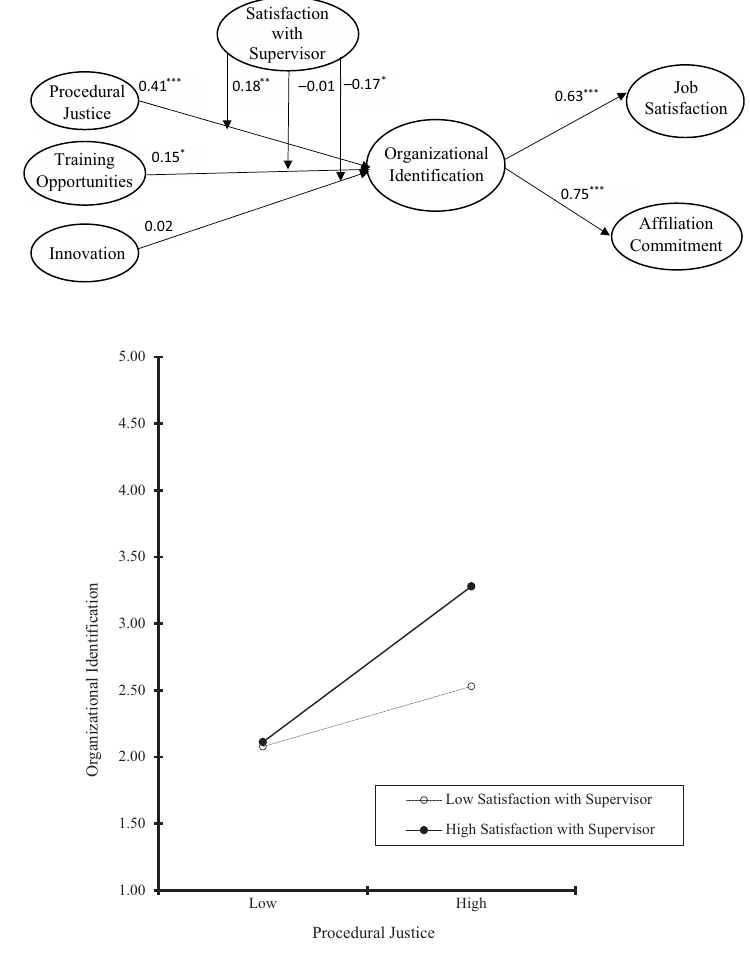
Figure 2. Completely